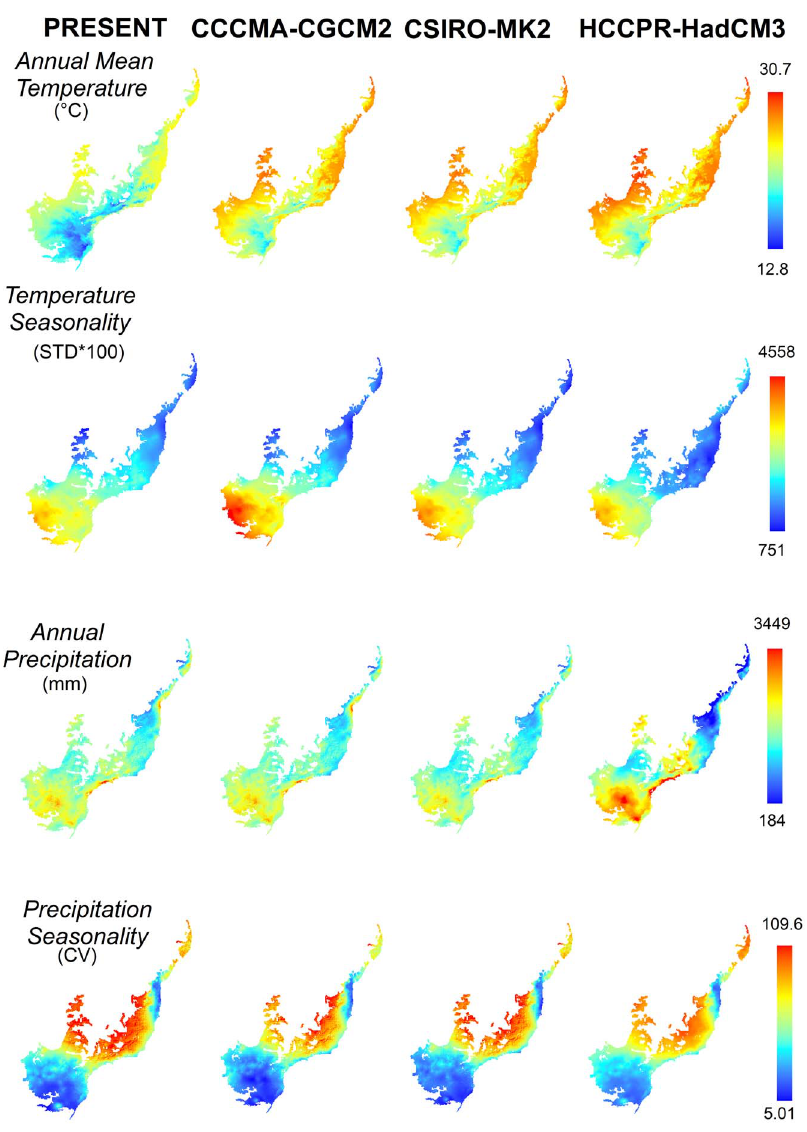
Figure 5. Expected changes for the four climatic variables used to model species’ ecological niches in the Atlantic Forest Biodiversity Hotspot, Brazil. Maps show present conditions and values for future climate models CCCMA-CGCM3, CSIRO-MK2, and HCCPR- HadCM3, in 2080).